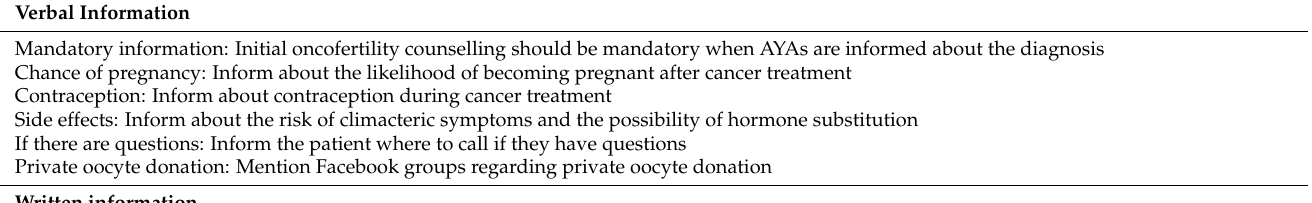
Table 4. Suggestions from the participants on how to improve the oncofertility counselling. Verbal